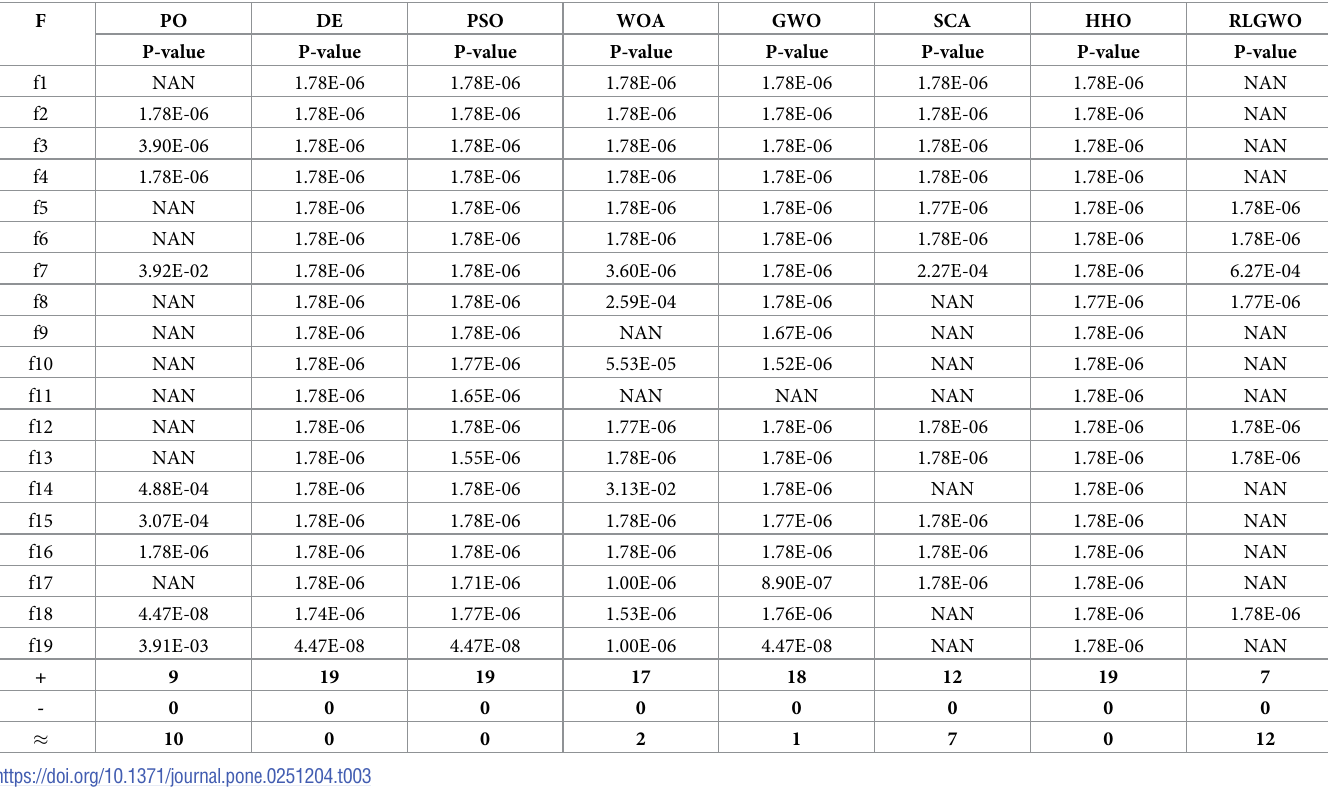
Table 3. p-values of the Wilconxon rank-sum test at 0.05 significance level for CRLPO against other eight algorithms on 19 benchmark functions from Table 1 with 30 dimensions. F